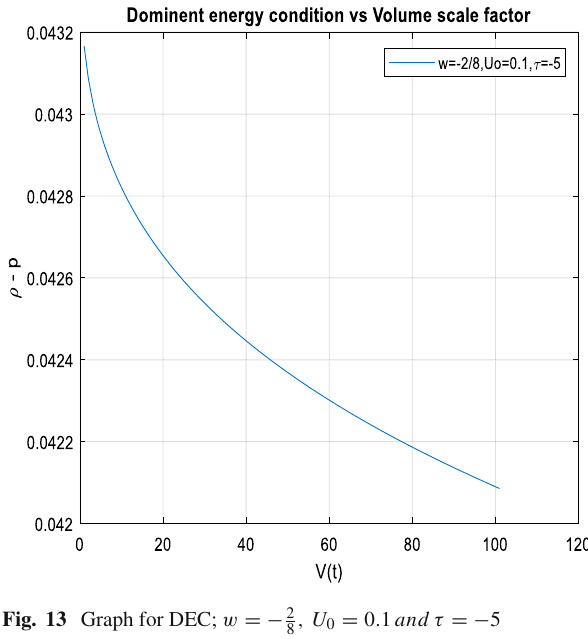
Fig. 13 Graph for DEC; w = − 2